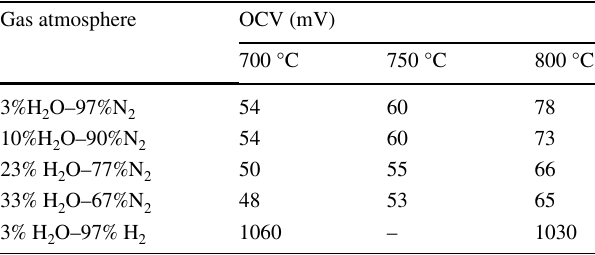
Table 1 Measured OCV data for symmetrical cell with a cell